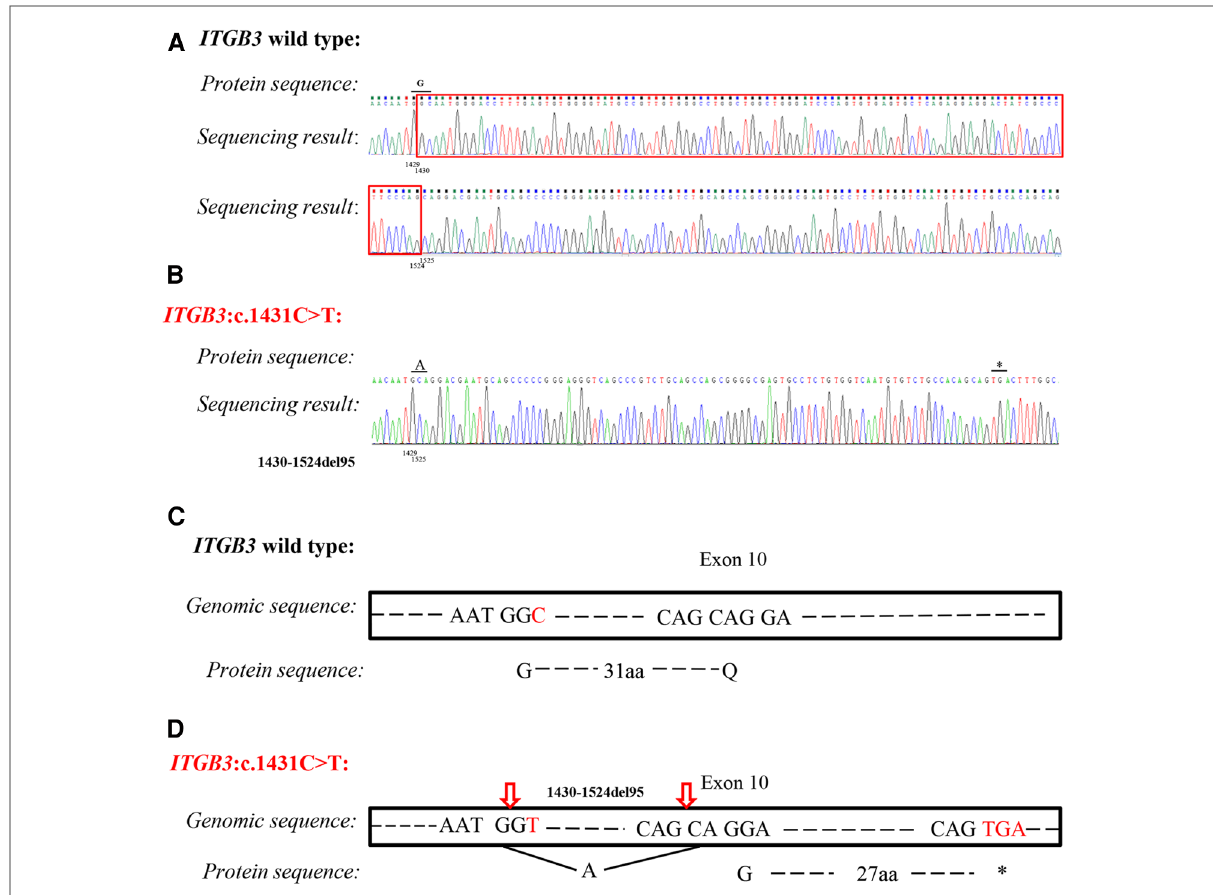
FIGURE 3 Analysis of silent variant c.1431C>T (p. G477=) of ITGB3 gene . Sequencing results of ITGB3 cDNA from a healthy control ( A ) and proband ( B ). The mutation caused 95 base pairs deletion (c.1430_1524del) and frameshift and then ITGB3 was truncated by a creation of a premature stop codon. ( C ) Splicing schematic representation of exon 10 organization in wild type of ITGB3 gene. ( D ) Splicing schematic representation of exon 10 organization in mutant type ( ITGB3 : c.1431C>T). The amino acid encoded at position 477 was changed from Glycine to Alanine, and caused frameshift. ITGB3 was truncated after 30 amino acids translation (p.